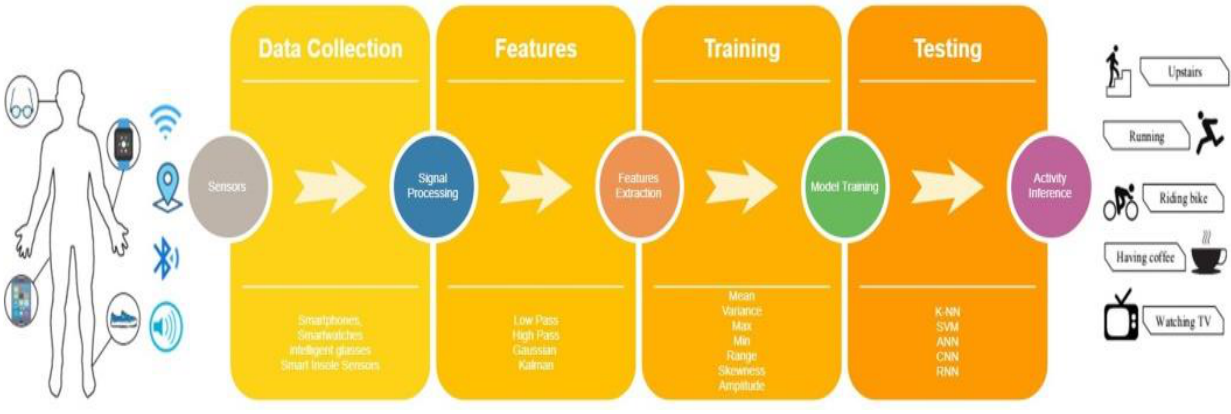
Figure 1. A high level picture of sensor or/and Smartphone based activity recognition using classical machine learning and deep leaning